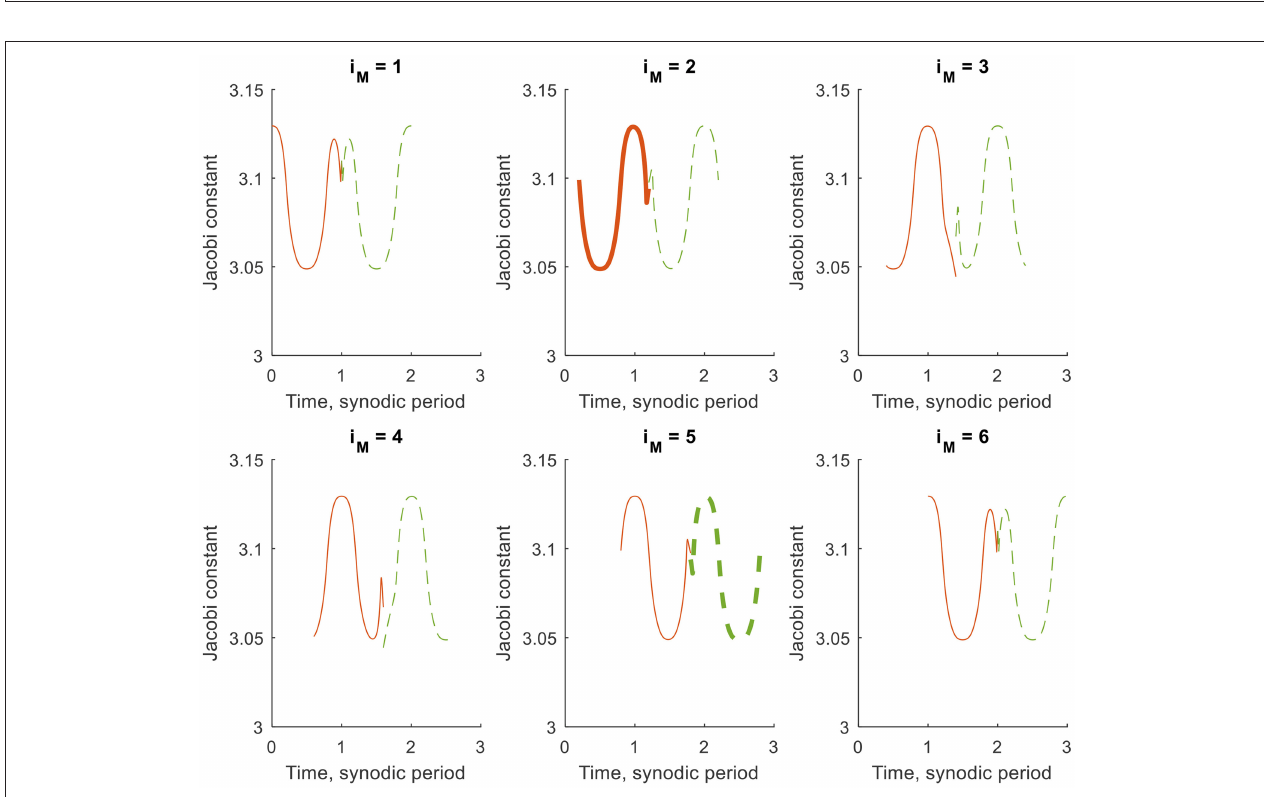
FIGURE 5 | Jacobi constant along six trajectories along the stable (red, solid) and unstable (green, dashed) manifolds of orbit 1, where i M = i U M = i S M .